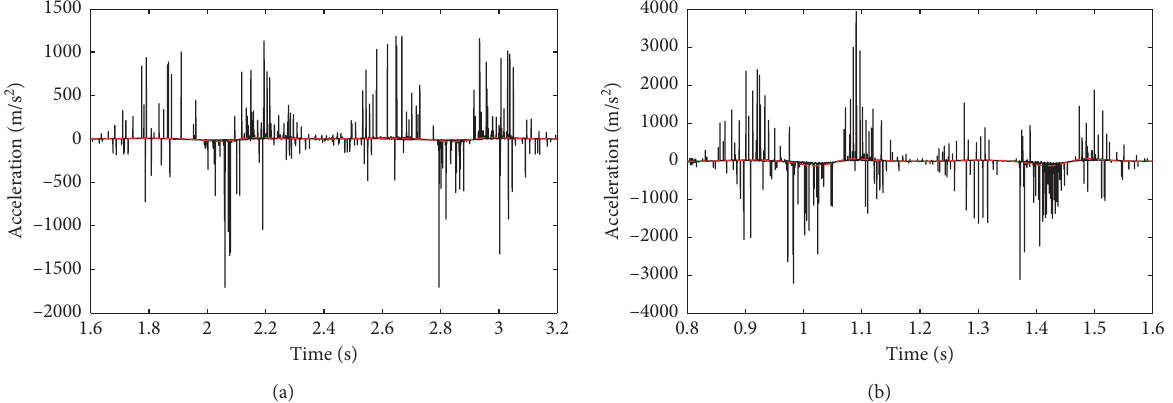
Figure 18: Acceleration of the slider. (a) ω